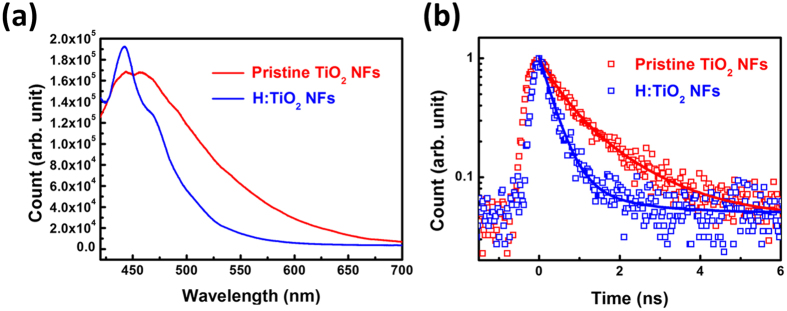
(a) PL spectra and (b) μ-TRPL spectrum of pristine TiO2-650 NFs and H:TiO2-650 NFs excited by 375 nm picosecond pulse laser.